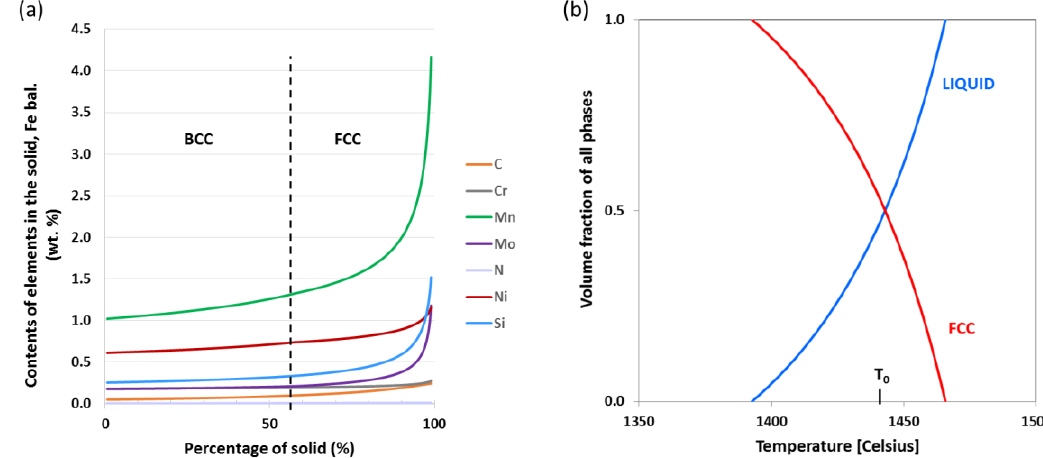
Figure 11. ( a ) Evolution of the composition of the solid phases (BCC and FCC) during solidification of the 18MND5 base metal, computed with Thermo-Calc ® and the TCFE6 database, using a modified Scheil-Gulliver model: percentage of solid equal to zero corresponds to the axis of the dendrites and equal to 100% to their outer shell; ( b ) Liquid-solid phase equilibria for the composition (in wt. %) of the last austenite solidified at the outer shell of the dendrites: Cr = 0.27, Ni = 1.16, Mn = 4.17, Mo = 1.18, Si = 1.52, C = 0.24, N = 0.014, Fe = bal.